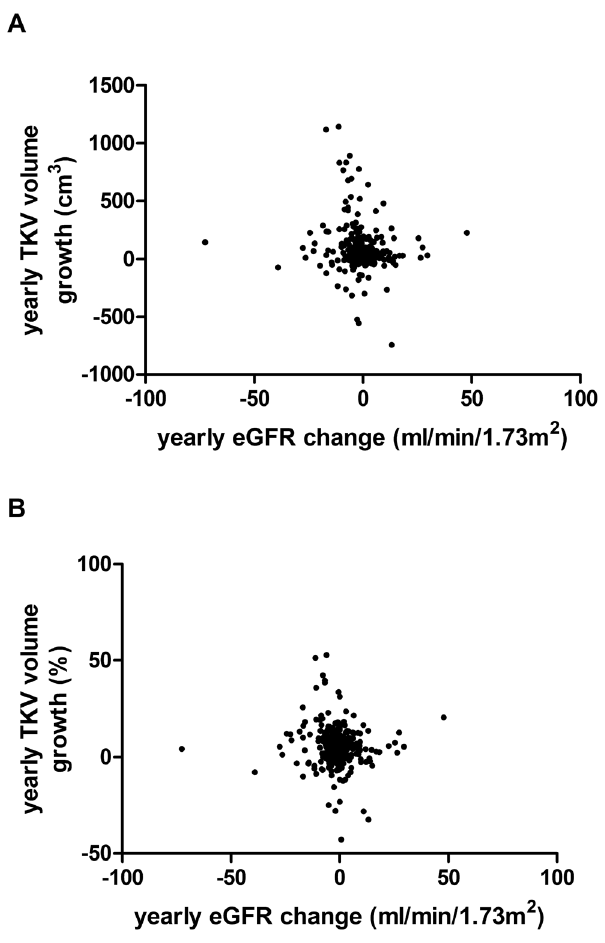
Figure 6. Correlations between yearly TKV growth and eGFR change in ADPKD patients. A) Scatter plot between yearly eGFR change and yearly TKV volume growth (cm 3 ) (n=372). Spearman’s rho is –0.119 ( P =0.022). Only patients . 18 years and # 60 years are included. B) Scatter plot between yearly eGFR change and yearly TKV volume growth (%) (n=372). Spearman’s rho is –0.055 ( P =0.288). Only patients . 18 years and # 60 years are included.